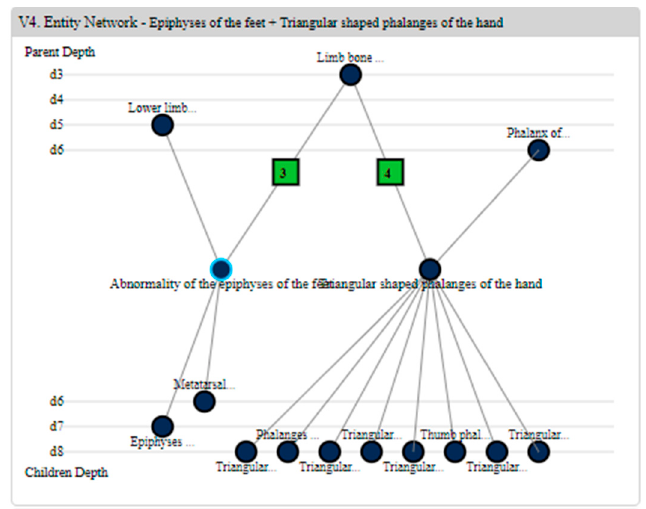
Figure 17. The Entity Network Panel depicting a low-level graph-like abstraction of specific ontology entities within the ontology network: parents (super classes), children (sub classes), and shared inheritances. Ontology entities are represented by a blue filled circle and text label. In these regions, relations are depicted with lines which link ontology entities to reflect relationship and localized structure. When two ontology entities are selected, their shared network is depicted with an additional representation maintaining the relations between each, their shared inherited parent, and distance. Additional information is exposed by moving the mouse over.